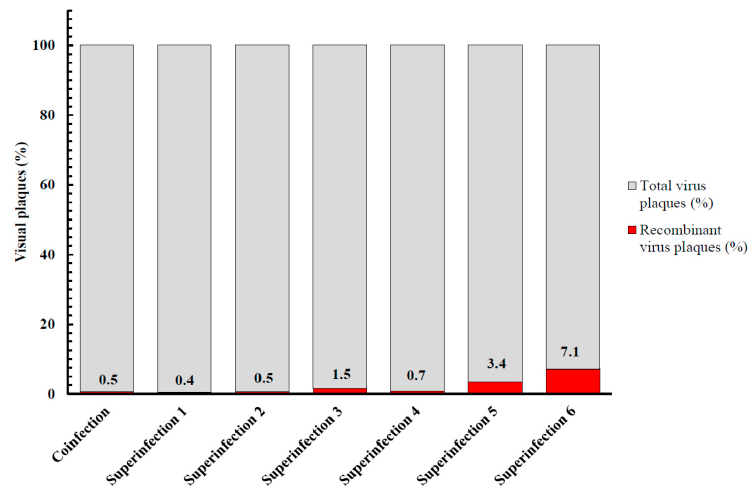
Figure 3. Total and recombinant virus yield in Vero cells. Co-infection, simultaneous infection of cells with Modified vaccinia virus Ankara-vectored influenza vaccine (MVA-HANP) and feline cowpox virus (fCPXV); Superinfection 1, primary infection with MVA-HANP and superinfection with fCPXV at two h post primary virus infection (ppi); Superinfection 2, primary infection with fCPXV and superinfection with MVA-HANP at two h ppi; Superinfection 3, primary infection with MVA-HANP and superinfection with fCPXV at four h ppi; Superinfection 4, primary infection with fCPXV and superinfection with MVA-HANP at four h ppi; Superinfection 5, primary infection with MVA-HANP and superinfection with fCPXV at six h ppi and Superinfection 6, primary infection with fCPXV and superinfection with MVA-HANP at six h ppi. Co-infection and superinfection were done at a m.o.i. of 5.0 for each virus and cultures were harvested three days ppi.